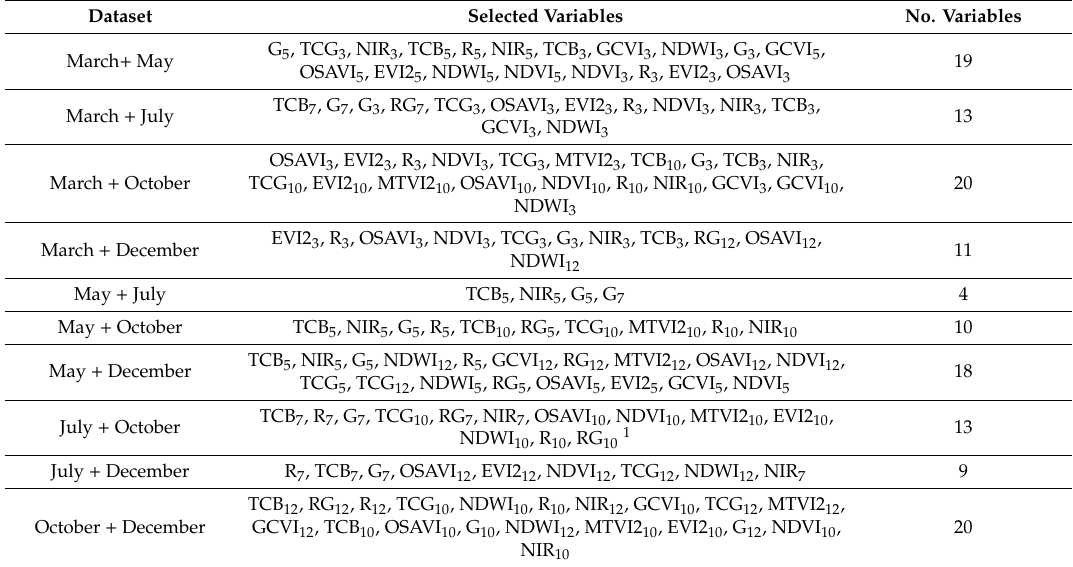
Figure 5. Predictive variable importance for the ten two-season combined datasets. ( a ) March + May; ( b )March + July; ( c ) March + October; ( d ) March + December; ( e ) May + July; ( f ) May + October; ( g ) May + December; ( h ) July + October; ( j ) July + December; ( k ) October + December. Table 5. Variable selection results for the final RF classification model for the ten two-season combined datasets.